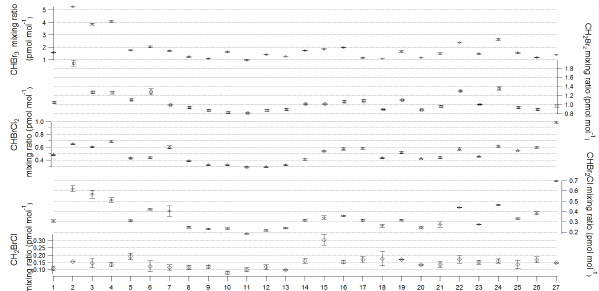
Figure 2. Bromocarbon mixing ratios for each station during PESC